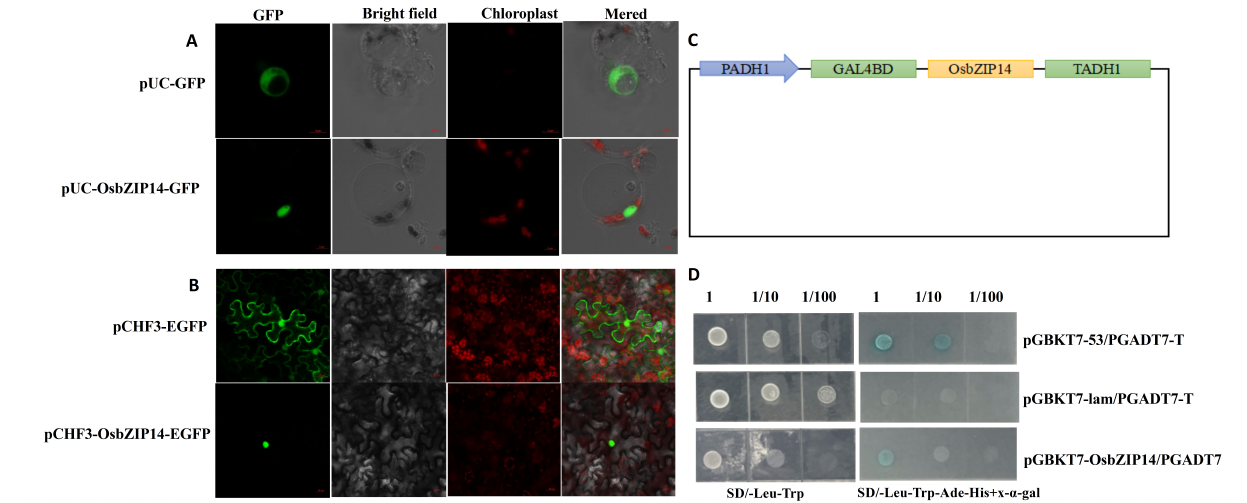
Figure 5. Subcellular localization and self-activation ability of OsbZIP14 gene. ( A ) The subcellular localization of OsbZIP14 protein in rice cells (Scale bar represents 5.0 µ m). ( B ) Visualization of the subcellular localization of the OsbZIP14 protein in tobacco epidermal cells (Scale bar represents 20.0 µ m). ( C ) Schematic representation of the PGBKT7-OsbZIP14 vector plasmid. ( D ) Assessment of the self-activation potential of the OsbZIP14 gene product